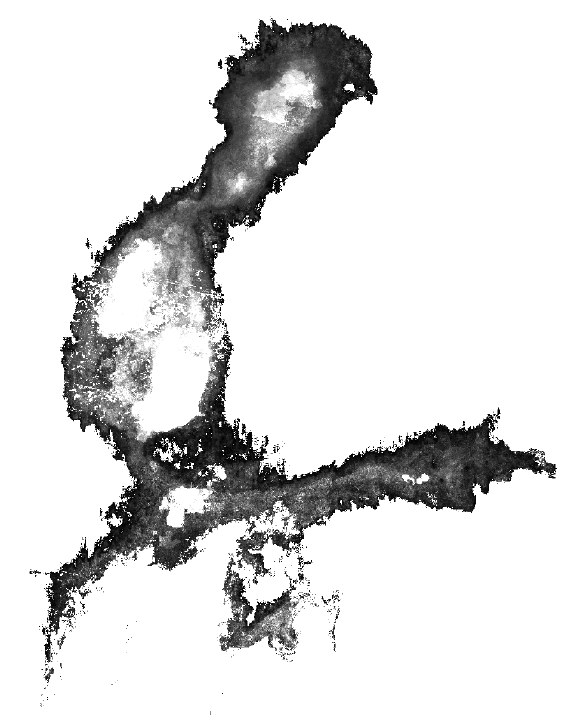
Fig. 5. Mean ice motion magnitude for two weeks before 5 March 2010 based on our SAR ice drift algorithm. Bright tones represent larger motion. The fast ice areas can be derived from these data. The bright areas in the southern parts of the Baltic Sea are open water. Open water has been masked off using the method presented in Karvonen et al. (2005) and set white in the figure.